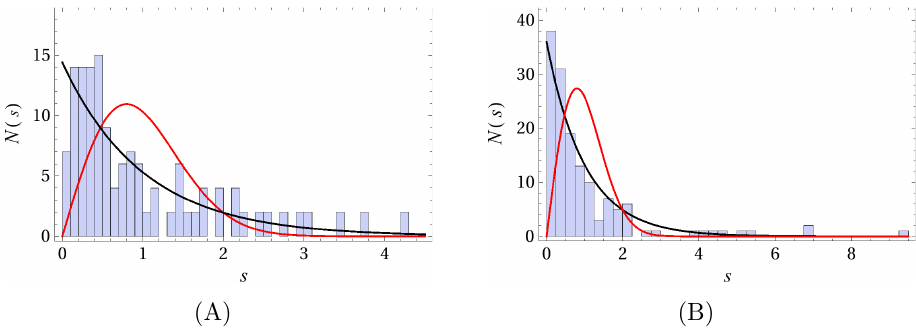
Figure 8. Distribution of neighboring energy level spacings N ( s ) for the Henon-Heiles Hamiltonian with (cid:15) = 0 . 1 (A) and (cid:15) = 1 . 5 (B). In each plot we compare the level distribution to the Poisson law ( exp( − s ) ) and the Wigner-Dyson law for orthogonal matrices ( s exp( − πs 2 / 4) ). The distribution is dominantly Poissonian even for large perturbations, although there is a small admixture of Wignerian statistics. The perturbative dynamics of the Henon-Heiles system is always weakly chaotic in quantum mechanics (despite being classically strongly chaotic for large enough (cid:15) ).